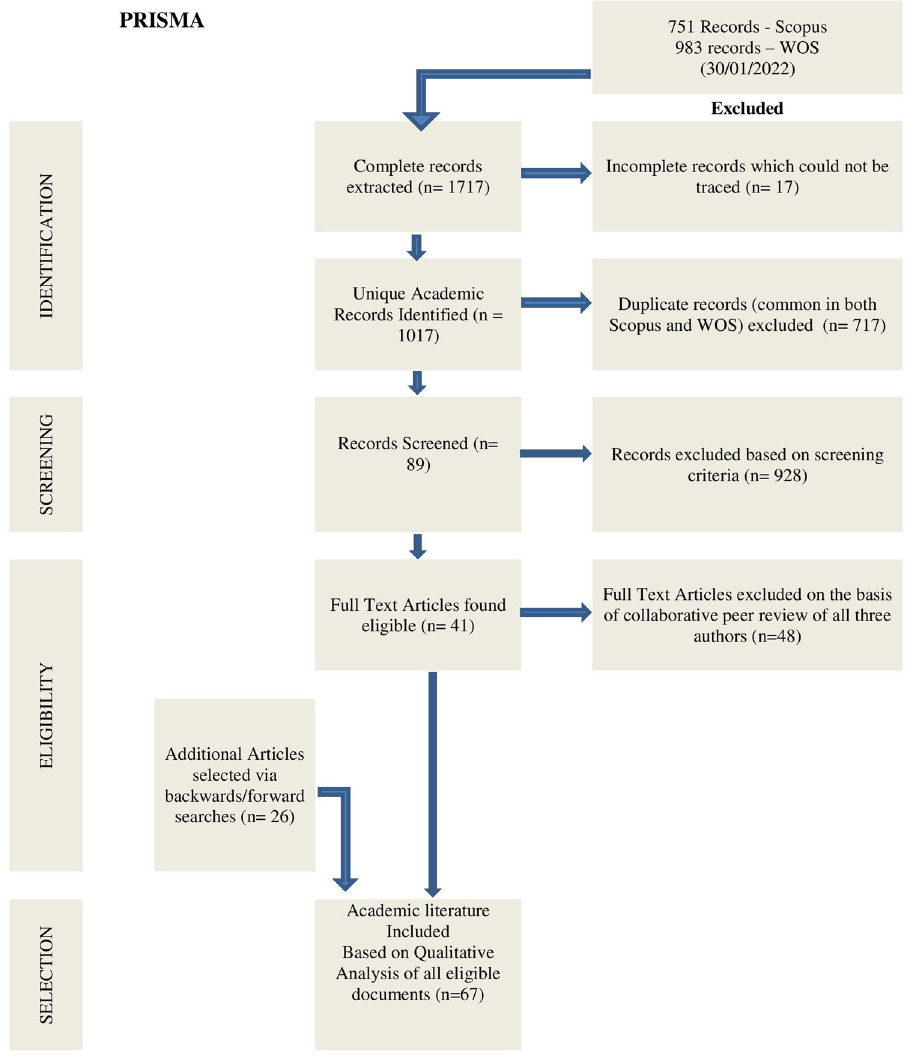
Fig. 1 The PRISMA Framework for this systematic review. Our initial result of 1734 documents (results as on 30 January 2022) was fi ltered by including only peer reviewed open access, full text English articles on Financial inclusion and women empowerment, resulting in 67 eligible documents. (author created).